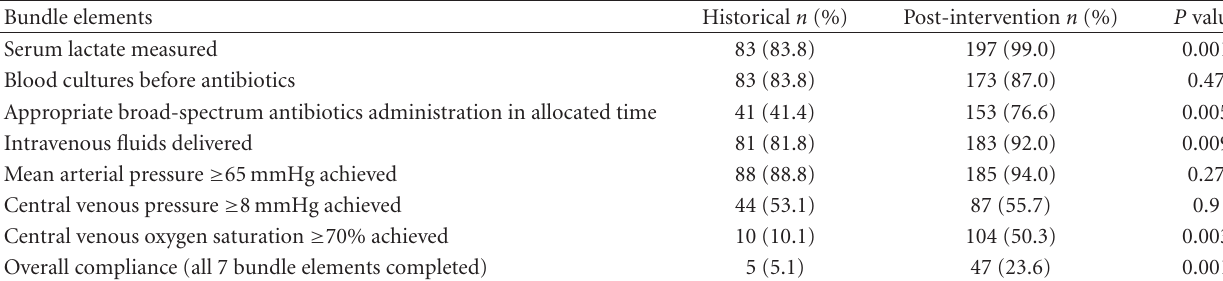
Table 2: Compliance with 6-hour sepsis resuscitation bundle elements.